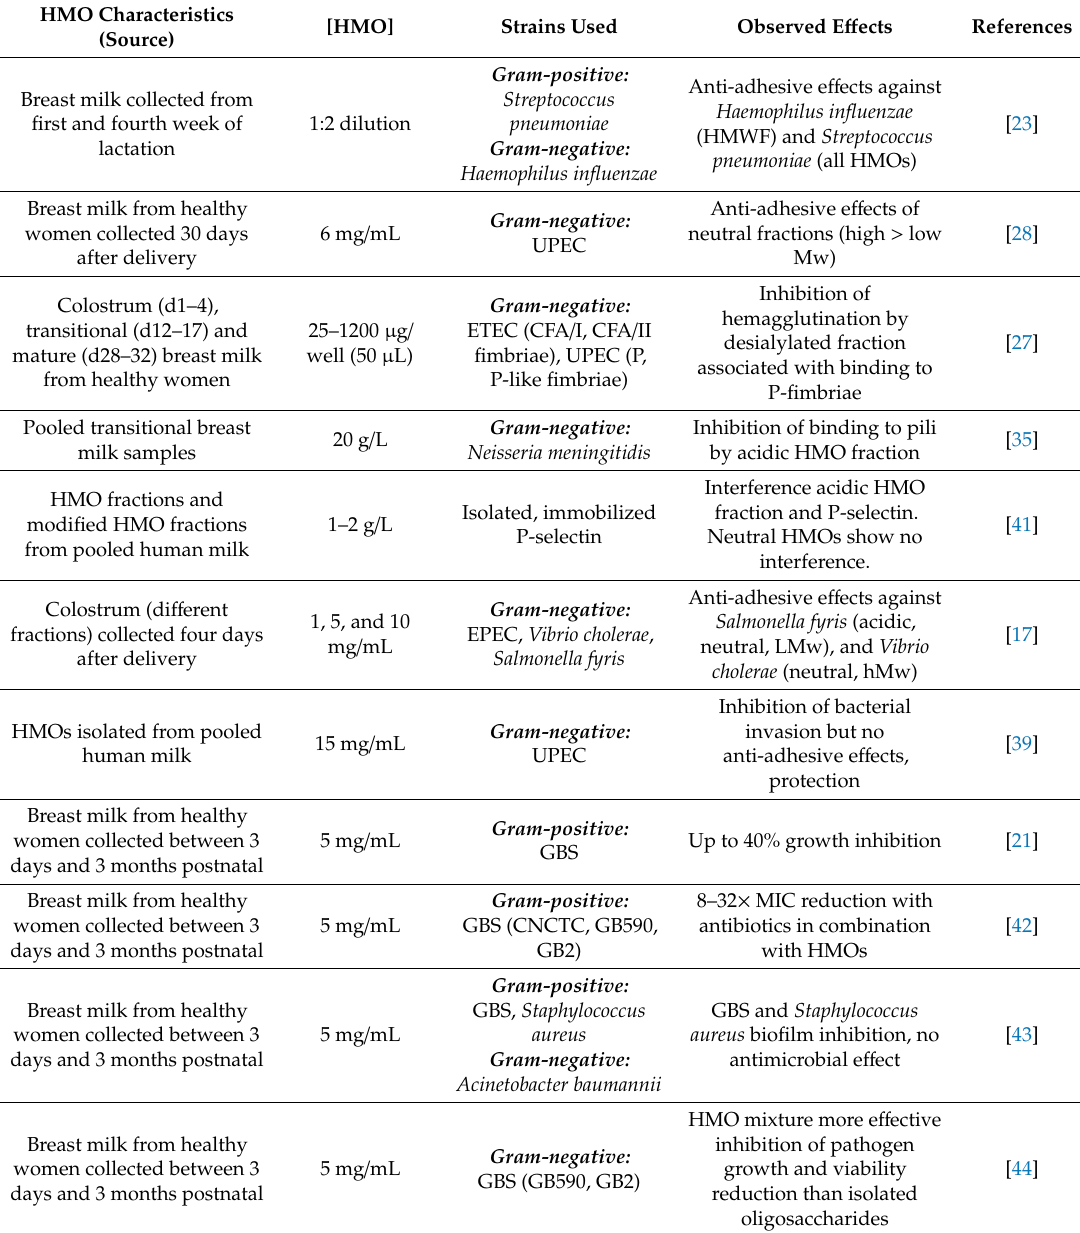
Table 1. Overview of the anti-pathogenic functionalities of HMO